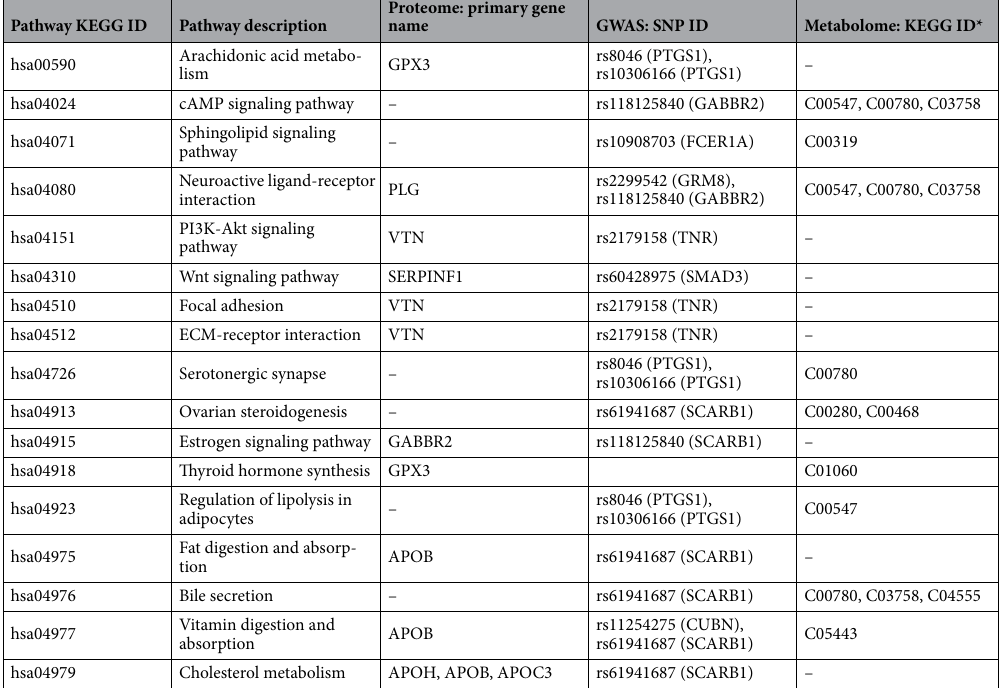
Table 3. The relationship between proteomic, metabolomic, and GWAS layers through biological processes in KEGG terms. *Refer to Table 2 for Metabolite KEGG IDs definition.